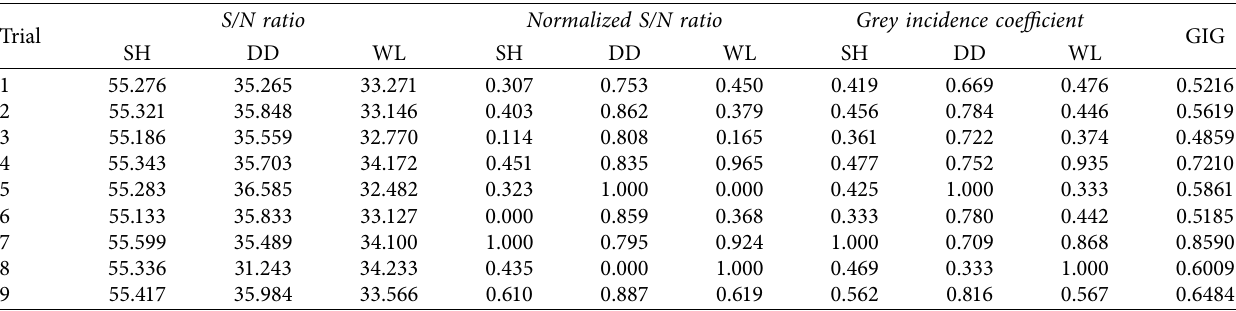
Figure 4: Microscopic examination of AISI 4140, EN36, and 16MnCr5 steels. Table 3: Quality index (GIG